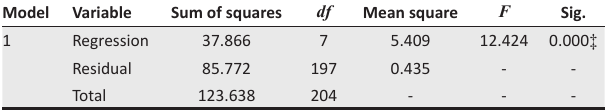
TABLE 5 : ANOVA: Risk and demographic factors. † Model Variable